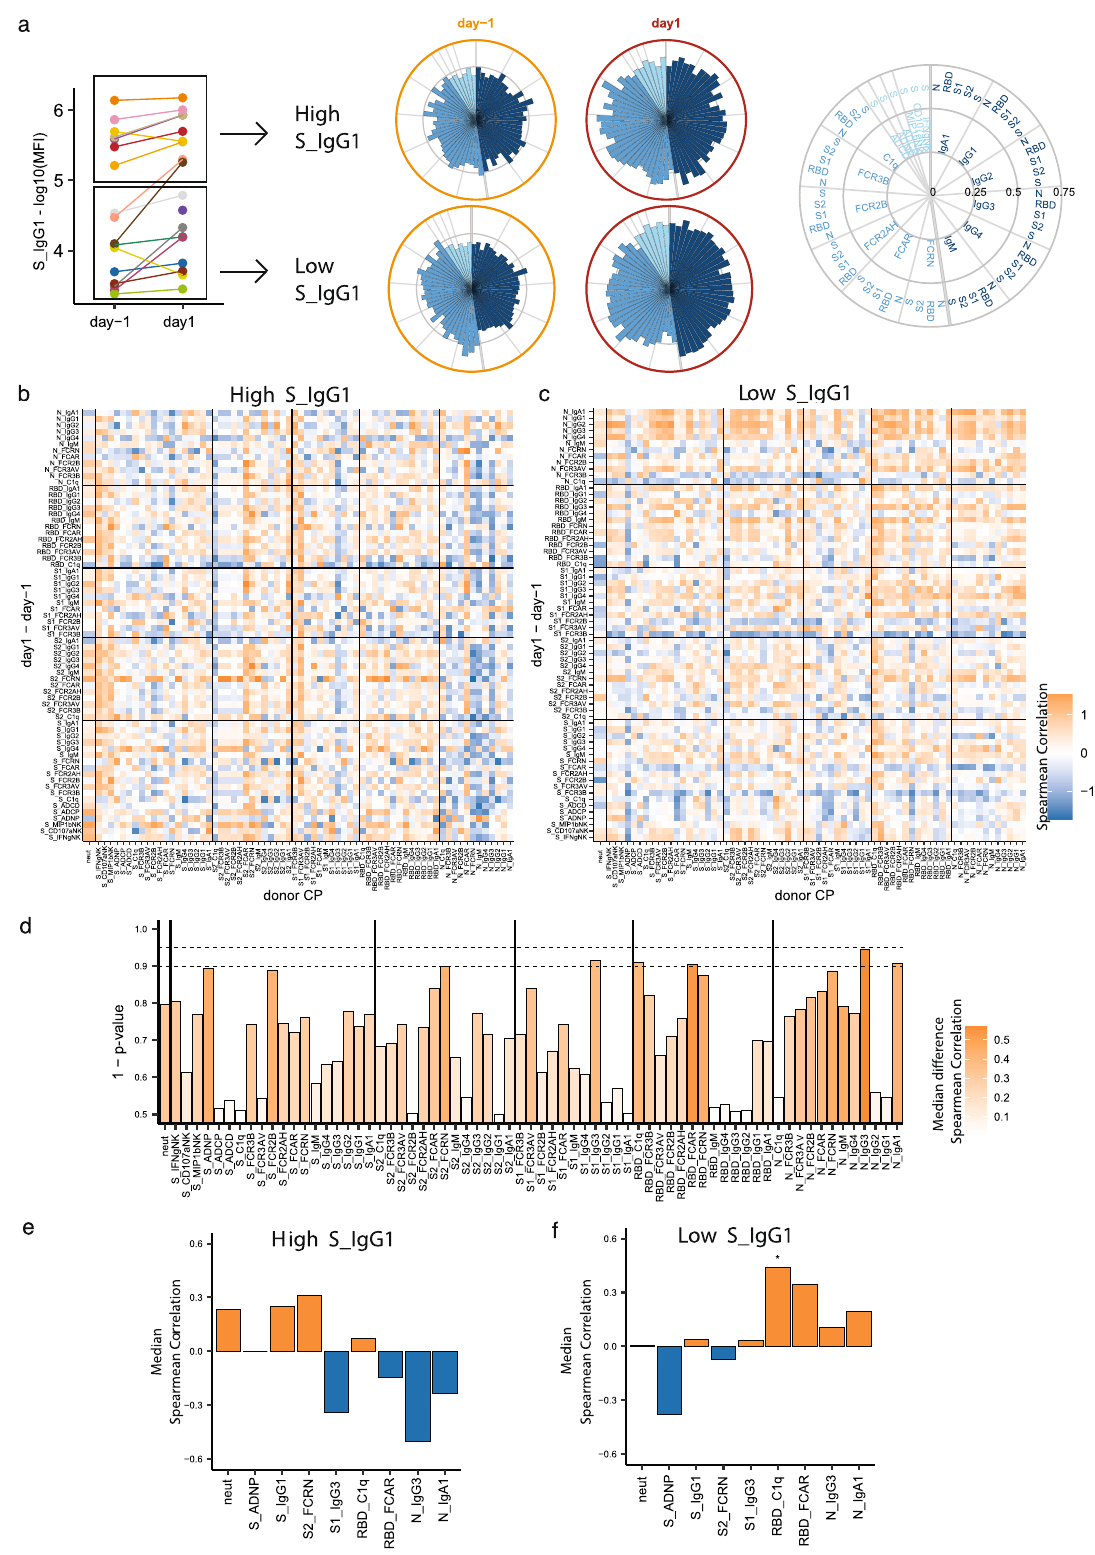
apparent bene fi t in some patients with severe disease, and its ability to clear virus and reduce in fl ammatory markers even when it does not affect overall clinical outcome. Pathogen neutralization has been traditionally regarded as the key mechanism by which antibodies may confer protection and therapeutic bene fi t 35,40 . Though many lines of evidence